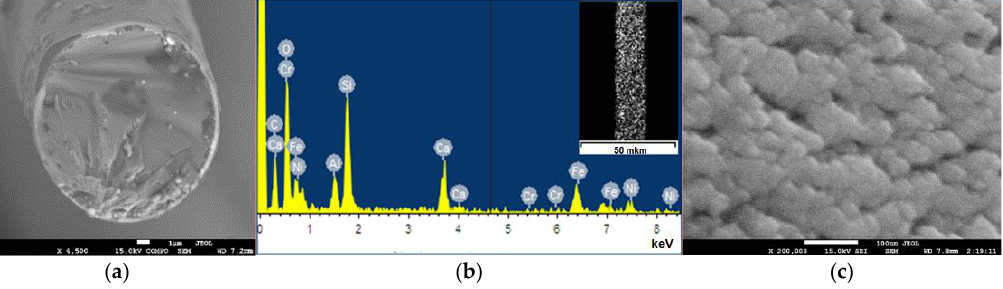
Figure 4. Microstructure of the surface of metallized glass fiber with SS304 film after two sputterings: ( a ) fiber projection; ( b ) corresponding EDA spectrum. ( c ) SS304 film at high magnification.